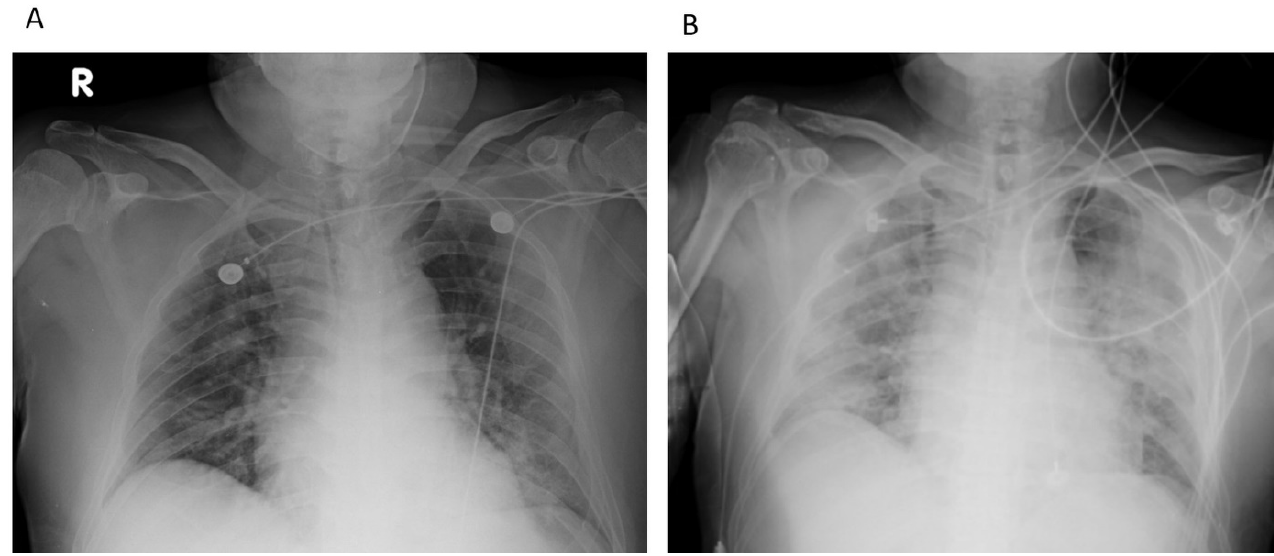
Figure 1. Representative case 1 (Patient 3): ( A ) Bilateral opacities on chest radiography taken in the emergency department. ( B ) Chest radiography revealed bilateral lung infiltration, indicating rapidly progressive diffuse pulmonary edema.